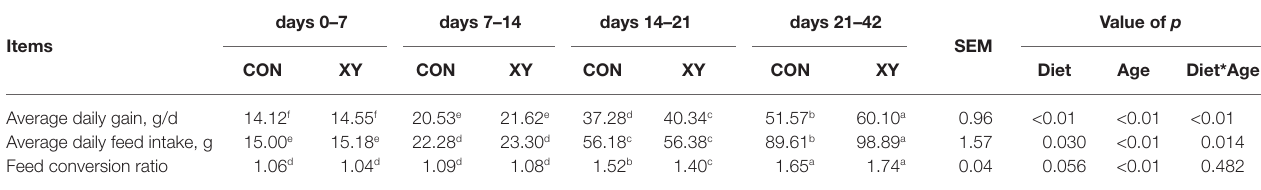
TABLE 2 | Effects of AT-xynA on growth performance of broilers. 1